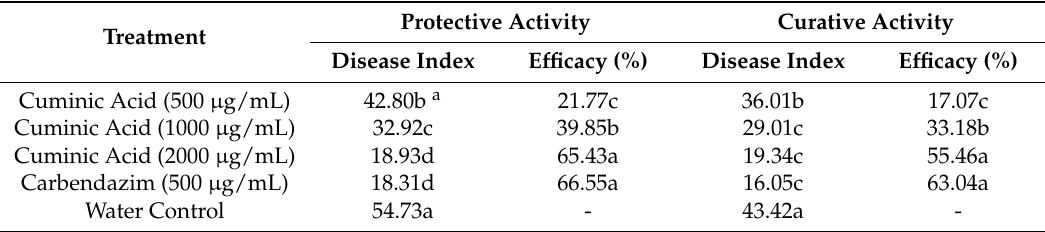
Table 3. Protective and curative activity of cuminic acid against C. lagenarium .